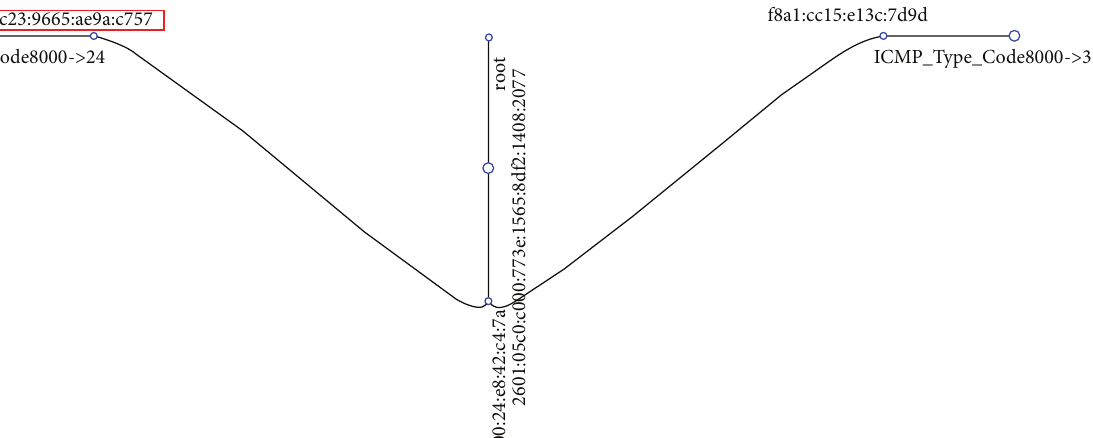
Figure 8: Attacker view of incoming traffic hitting the CN visualized.